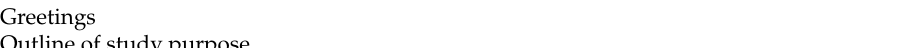
Table 1. Focus group